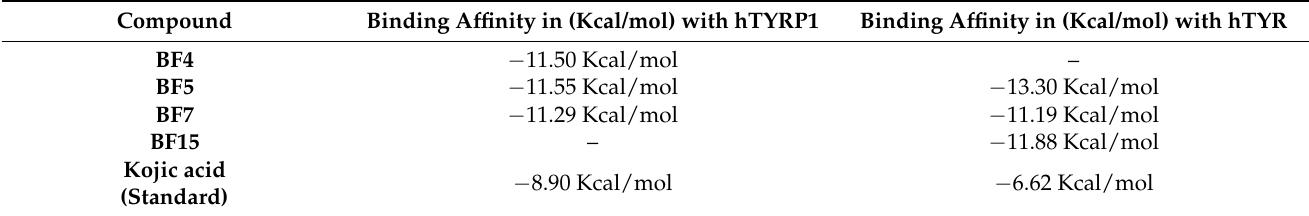
Figure 7. Three-dimensional conformational pose of BF5 with human tyrosinase-related protein-1 (hTYRP1) ( Upper panel ) and its two-dimensional pose ( Lower panel ). Table 1. Binding affinities of the best binding compounds with the hTyrosinase and hTYRP1